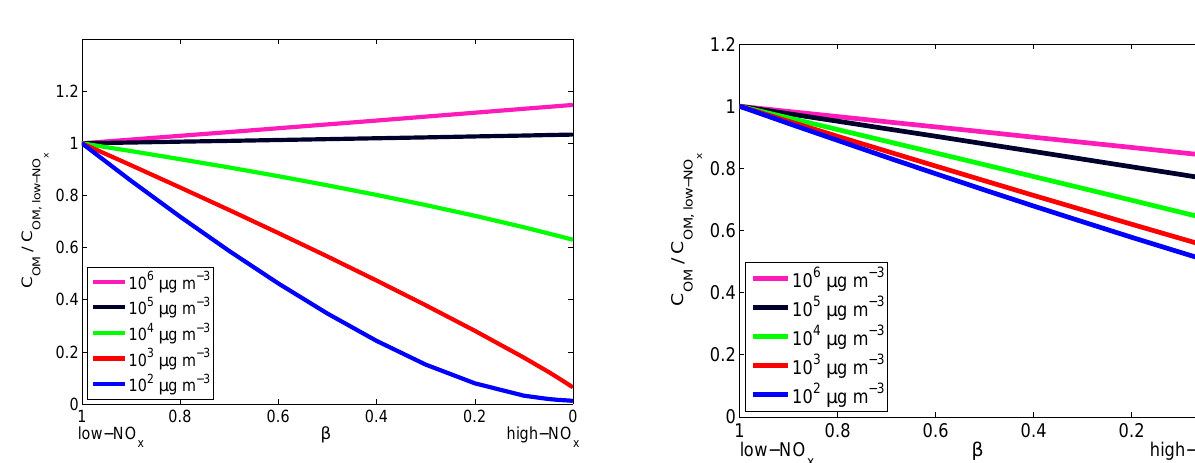
Figure 5. The effect of peroxy-radical branching on the aged sec- ondary organic aerosol concentration, C OM , after 10h of oxidation by 10 7 OHcm − 3 . As in Fig. 4 the x axis is the branching ratio for RO 2 reaction ( β ), where β = 1 corresponds to the low-NO x con- ditions dominated by RO 2 + HO 2 and β = 0 corresponds to high- NO x conditions dominated by RO 2 + NO. The y axis is the ratio of C OM at a given value of β to the low-NO x value. Each curve rep- resents a different amount of oxidized precursor, spanning 5 orders of magnitude from 10 2 to 10 6 µgm − 3